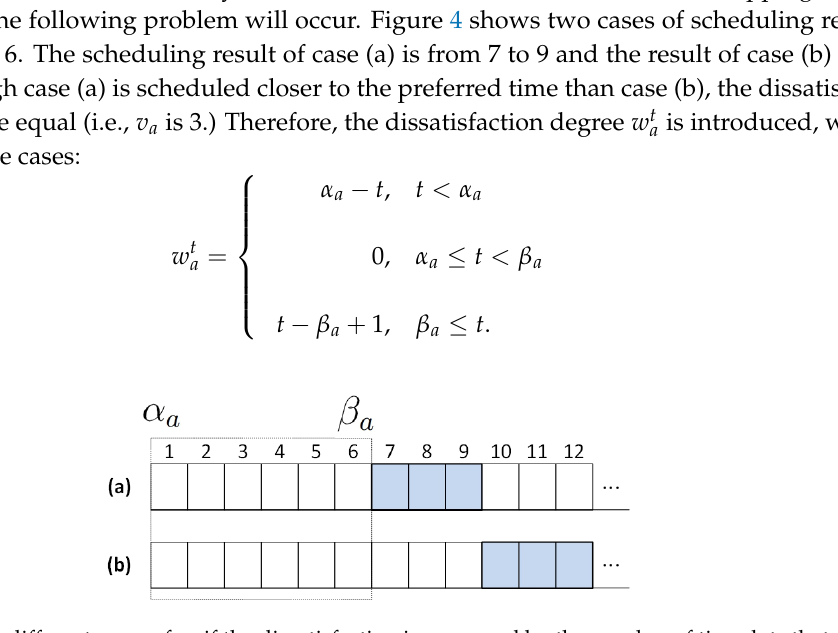
Figure 4. Two different cases of v a if the dissatisfaction is measured by the number of timeslots that are non-overlapping with preferred